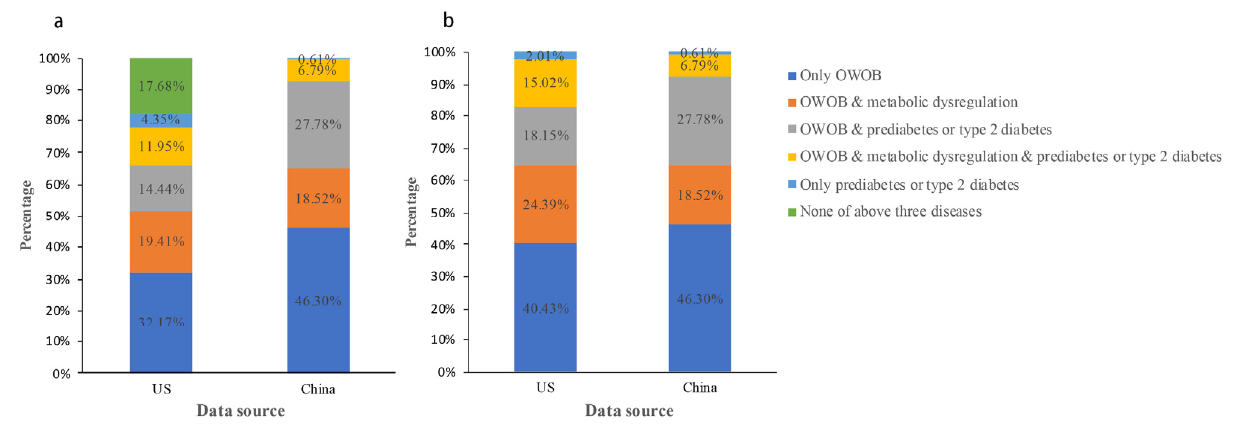
Figure 2. Characteristic composition of NAFLD participants ( a ) and MAFLD participants ( b ) in NHANES 2017–2018 and CPOOA. US and China correspond to the 2017–2018 National Health and Nutrition Examination Survey (NHANES) and the Comprehensive Prevention Project for Overweight and Obese Adolescents (CPOOA), respectively. ( a , b ) show the etiological composition of participants with metabolic-associated fatty liver disease (MAFLD) and participants with nonalcoholic fatty liver disease (NAFLD) in the two studies, respectively. Dark blue indicates the presence of the factor OWOB only, orange indicates the presence of both OWOB and metabolic dysregulation, grey indicates the presence of both OWOB and prediabetes or type 2 diabetes, yellow indicates the presence of all three factors: OWOB, metabolic dysregulation and prediabetes or type 2 diabetes, and light blue indicates the presence of only one factor: prediabetes or type 2 diabetes. Green means none of the above three factors were present. OWOB, overweight/obesity.